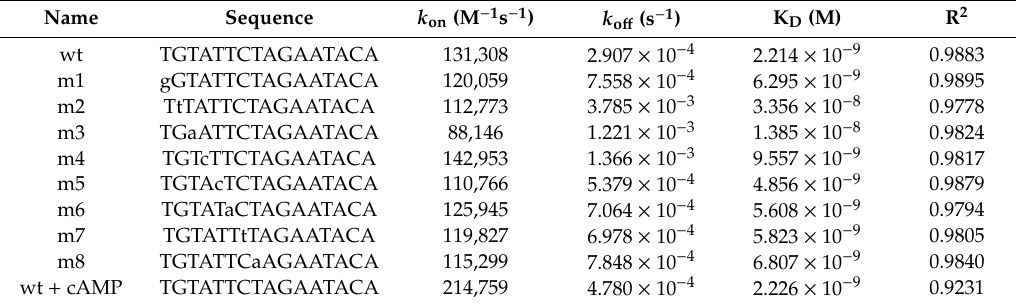
Table 1. TTHB099-DNA binding parameters for consensus and mutant